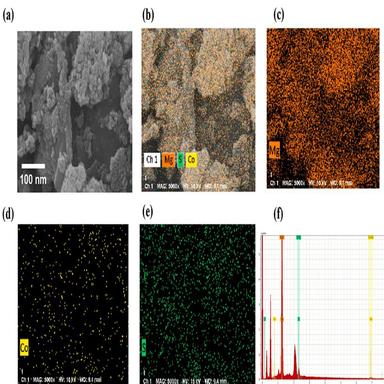
(a) SEM image of CoMgS nanostructure (b-f) EDX investigation of the Co, Mg, S.